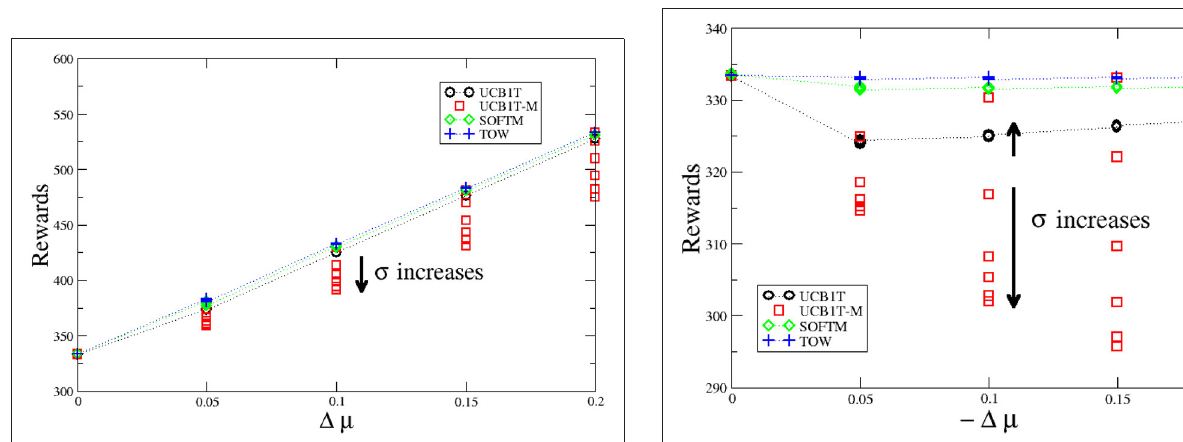
FIGURE 2 | Performance comparison between four learning algorithms for MAB where PDFs are δ ( 1 3 ) and N ( 1 3 + 1 µ , σ 2 ). 1 µ is negative (cases where machine A is correct